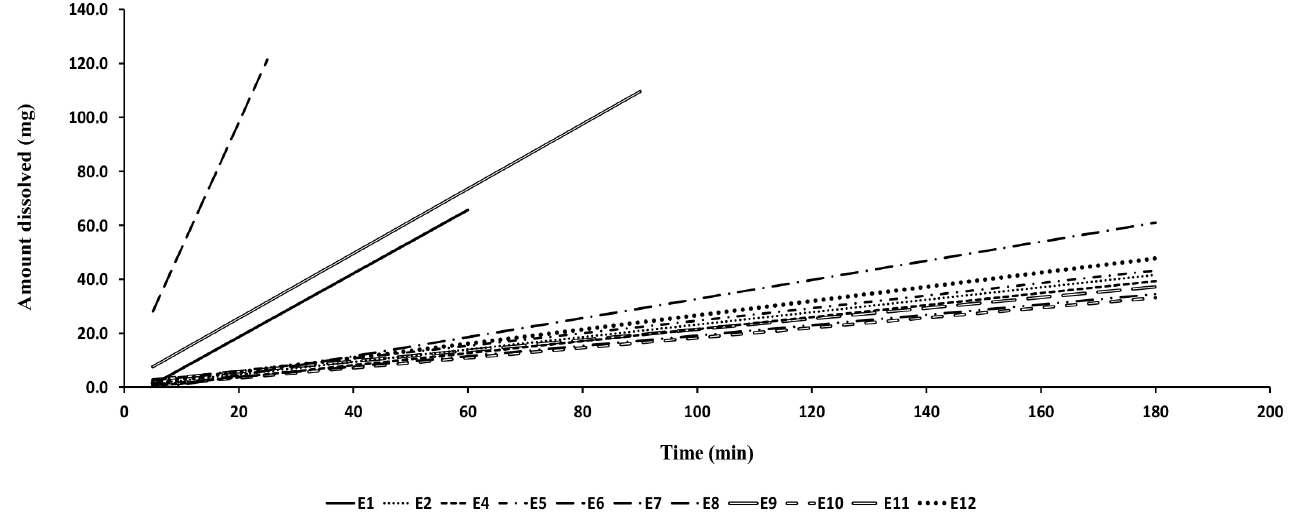
FIGURE 2 – Linear regression of the points pertaining to the amount of amlodipine besylate dissolved against time, in the intrinsic dissolution tests carried out according to Table